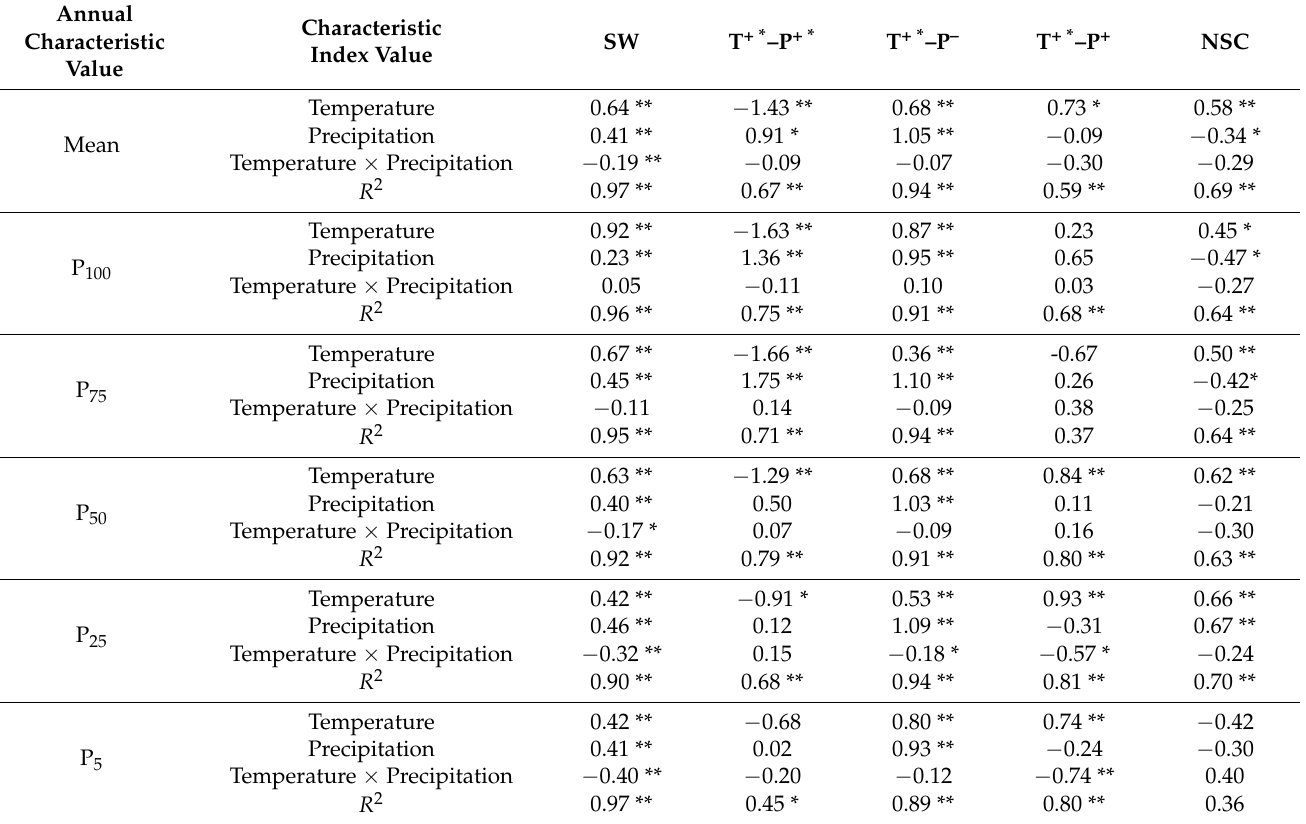
Table 3. Multiple linear regression results of vegetation NDVI with temperature and precipitation using a 15-year sliding window. T +* –P +* , significant increases in temperature and precipitation; T +* –P − , a significant increase in temperature related to a decrease in precipitation; T + * –P + , a significant increase in temperature related to an increase in precipitation; NSC, no significant change. “+/ − ” in the upper right corner denotes an increase/decrease in temperature or precipitation; Temperature × Precipitation represents the interaction term between temperature and precipitation; R 2 represents the entire model’s overall coefficient of determination. “*” and “**” to the right of the numbers represent the significance of the regression coefficient and overall model at the 0.05 and 0.01 levels,